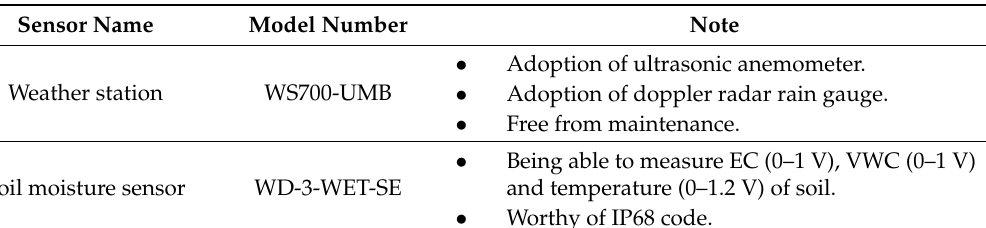
Table 2. Sensor information used in this study.